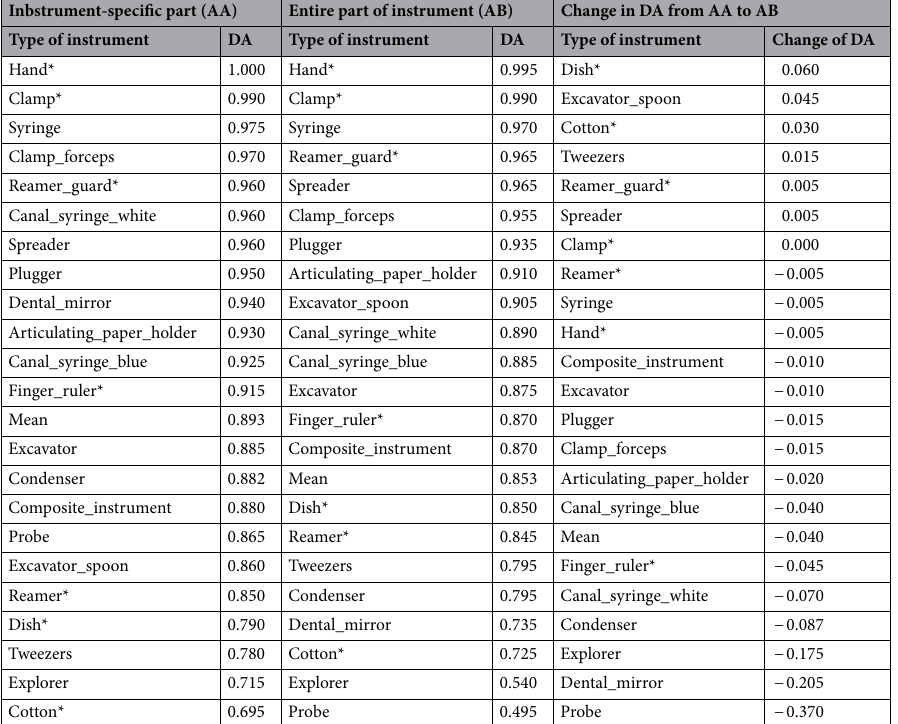
Table 3. DA of each instrument and changes according to annotation method (YOLOv4).